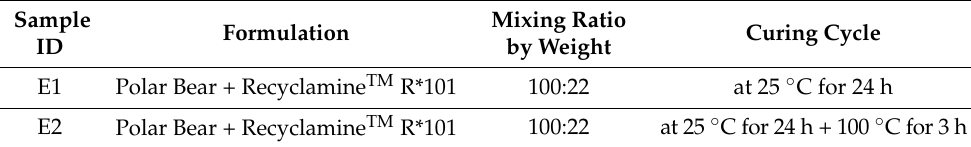
Table 1. Epoxy resin systems